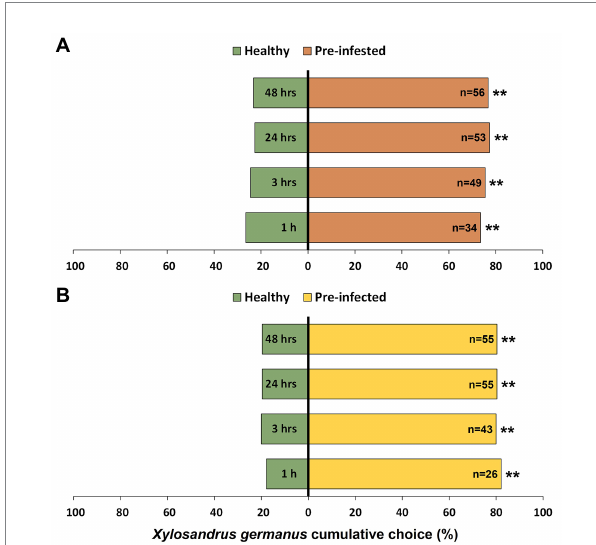
FIGURE 2 Effects of wood treatment on host choice of Xylosandrus germanus adult females. (A) Choice assays between previously infested bolts (six days earlier, by a foundress of the same species), indicated by orange bars, and untreated controls, indicated by green bars. (B) Choice assays between previously infected bolts (six days earlier, by the main fungal mutualist A. grosmanniae ), indicated by yellow bars, and non-inoculated controls, indicated by green bars. A total of 60 beetle females were tested and the choice, as measured by tunneling into one of the two bolts (pre-infested or pre-infected vs. control), was monitored at 1 h, 3 h, 24 h, and 48 h. Asterisks denote significant differences: ** p < 0.001. n , number of insects choosing a source.